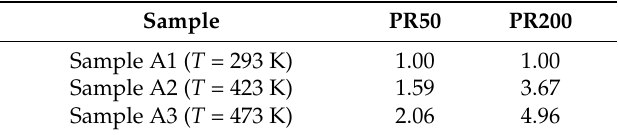
Table 4. SEM-FEG metallographic results (based on nine measurements ).